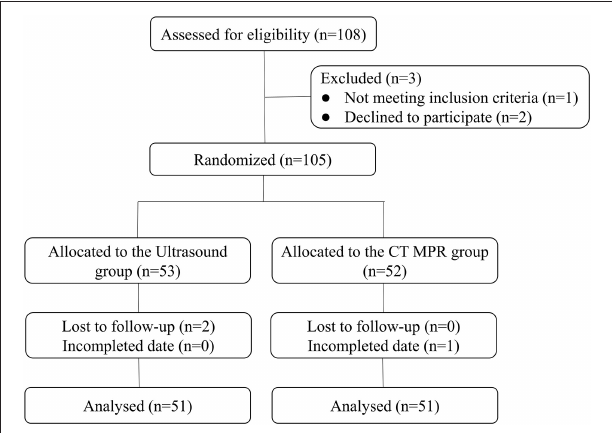
FIGURE 4 | Study flowchart of patients in the second part.